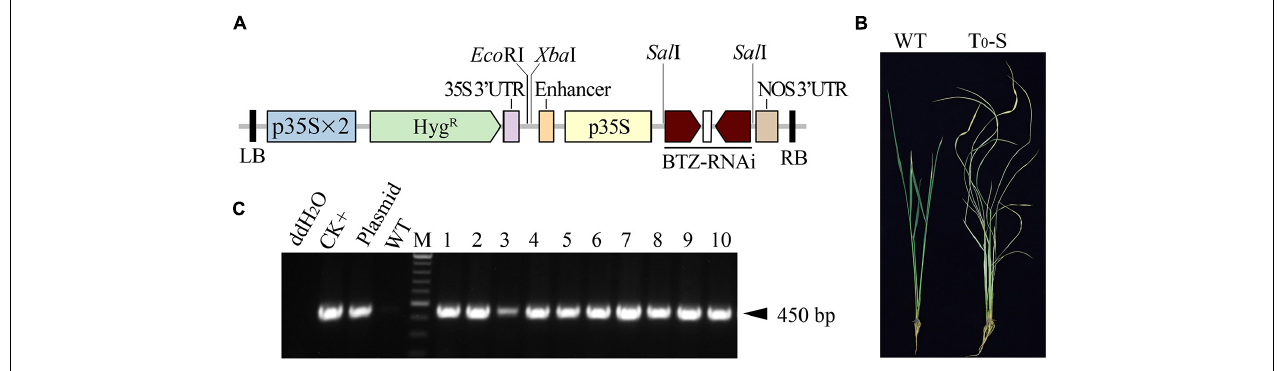
FIGURE 1 | PCR screening and BTZ S testing of T 0 transformants carrying the AT72 T-DNA fragment. (A) Schematic of the T-DNA region of the AT72 vector. p35S, cauliflower mosaic virus 35S promoter; p35S × 2, double 35S promoter; Hyg R , hygromycin resistance gene; 35S 3 (cid:48) -UTR, the 3 (cid:48) -UTR of the 35S promoter; BTZ-RNAi, the inverted repeat sequence of the 304 bp fragment of CYP81A6 ; LB and RB, left and right borders of the T-DNA, respectively; NOS 3 (cid:48) -UTR, the 3 (cid:48) -UTR of Nos; Eco RI, Sal I and Xba I are restriction enzyme sites. (B) Symptoms of a wild type (WT) Ilmibyeo sub-plant and a transgenic T 0 BTZ S sub-plant (T 0 -S) 7 days after a BTZ foliar spray. (C) Agarose gel electrophoresis of PCR amplicons was created using Hyg R -specific primers. CK+: transgenic positive plant; Plasmid: HPE203 plasmid DNA with Hyg R ; M: Thermo Scientific GeneRuler DNA Ladder Mix (SM0333); 1–10: T 0 transgenic plants; UTR: untranslated